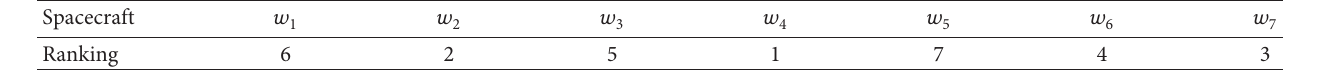
Table 24: Hierarchical ranking of spacecraft.